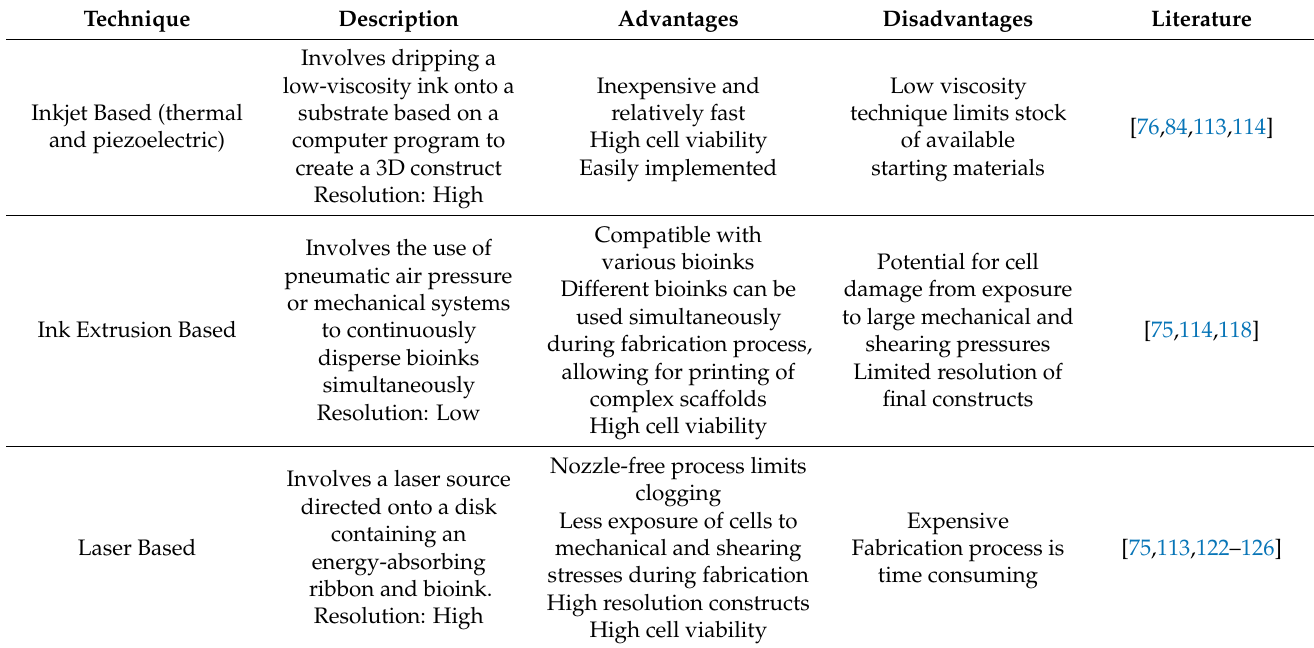
Table 2. Summary of current bioprinting